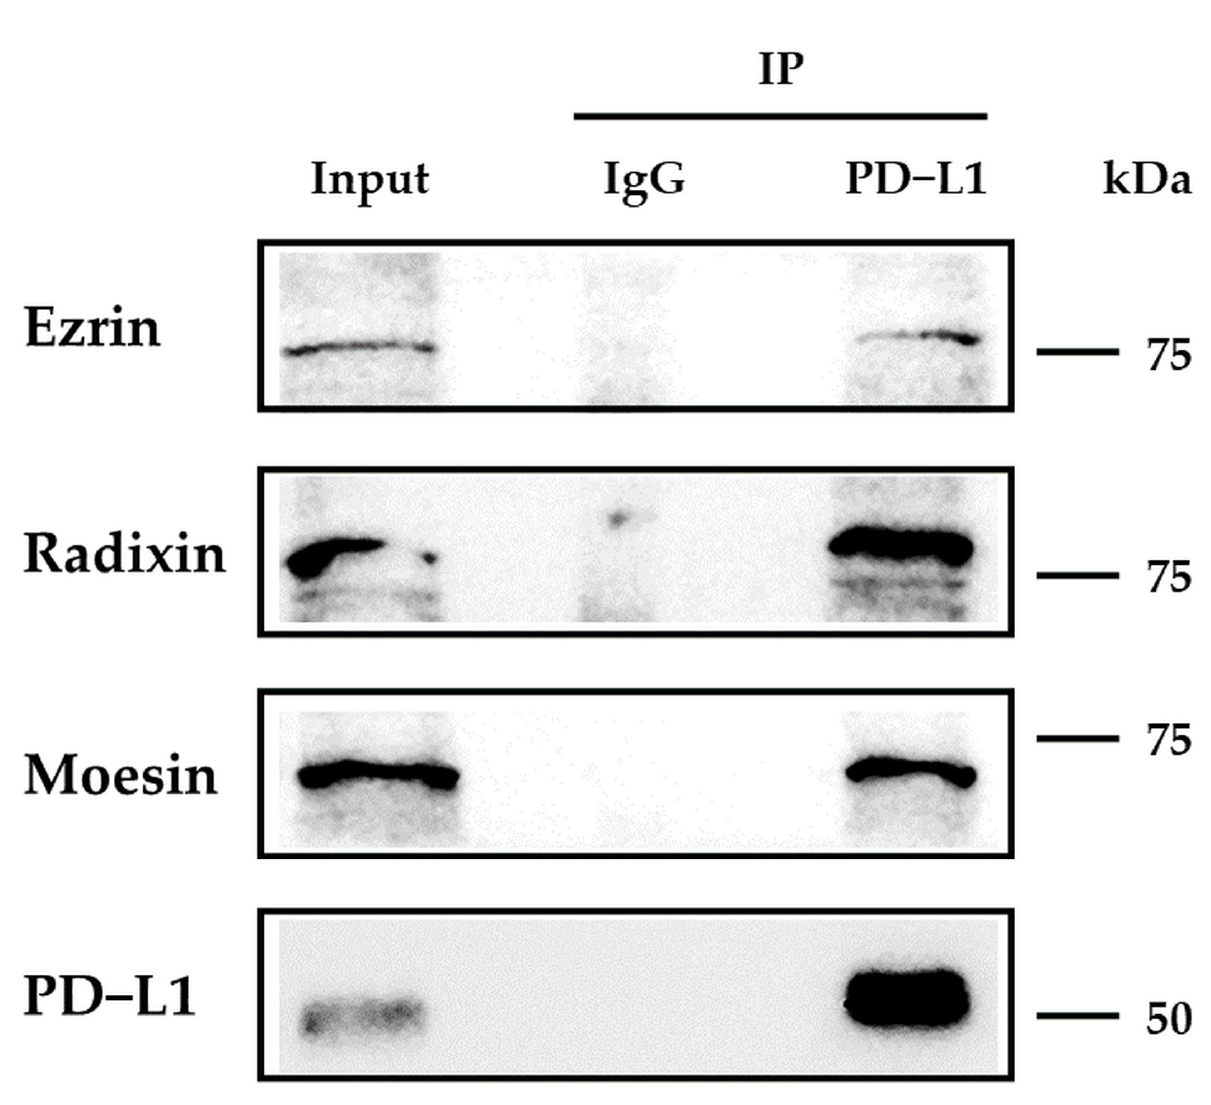
Figure 4. Immunoblots for programmed death ligand-1 (PD-L1) co-immunoprecipitation in HEC- 151 cells. Immunoreactive bands of ezrin, radixin, moesin, and PD-L1 in the input and those co-immunoprecipitated (IP) with a control IgG or an anti-PD-L1 Ab. Molecular weights;